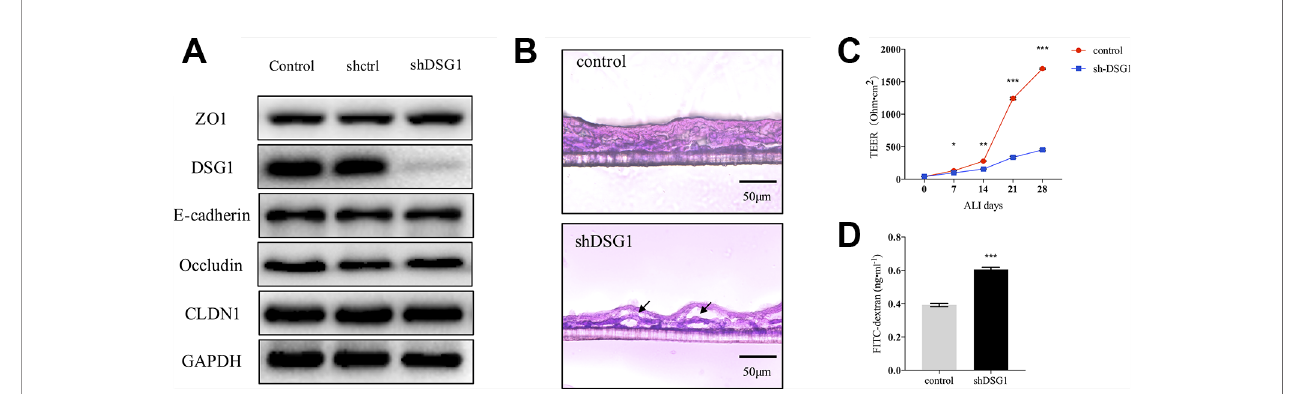
FIGURE 5 | Bronchial epithelial barrier depends on DSG1. 16HBE cells (5×10 4 per well) were seeded on Transwell ® permeable supports and transfected by shDSG1 after 24 h. After a con fl uent monolayer was formed, culture medium in the upper chamber was removed and cells were differentiated at air-liquid interface for 28 days. (A) shDSG1 signi fi cantly reduced the protein expression of DSG1, but displayed negligible effects on other junction proteins; (B) the polyester membrane of inserts was fi xed in 4% paraformaldehyde and embedded in tissue freezing medium. Subsequently, sections at 6 m m were prepared and H&E staining of strati fi ed cells was utilized to observe the effect of DSG1 knockdown (scale bar = 50 m m); Besides, the in fl uence of shDSG1 on epithelial barrier integrity was also evaluated by (C) TEER measurements on ALI day 0, 7, 14, 21, and 28; and (D) 4kD FITC-dextran in fl ux on day 28. Collectively, epithelial barrier was prominently compromised after DSG1 knockdown as evidenced by observable cellular separation, markedly reduced TEER and hyperpermeability of macromolecule. (All data represent mean ± SD from three independent experiments performed in triplicate, n = 3, * P < 0.05, ** P < 0.01, *** P < 0.001 versus control). HDM, house dust mite; DSG1, desmoglein 1; TEER, transepithelial electrical